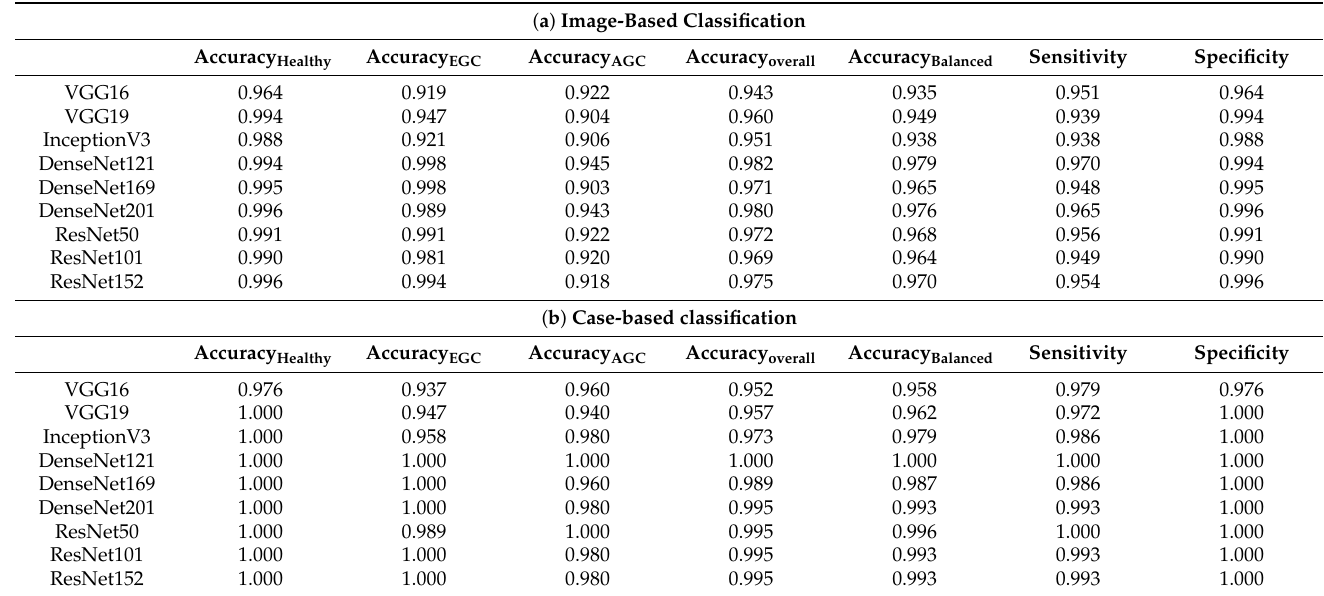
Table 1. Comparison of CNN models for image classification. Values in bold indicate the results of the CNN model with the highest performance.